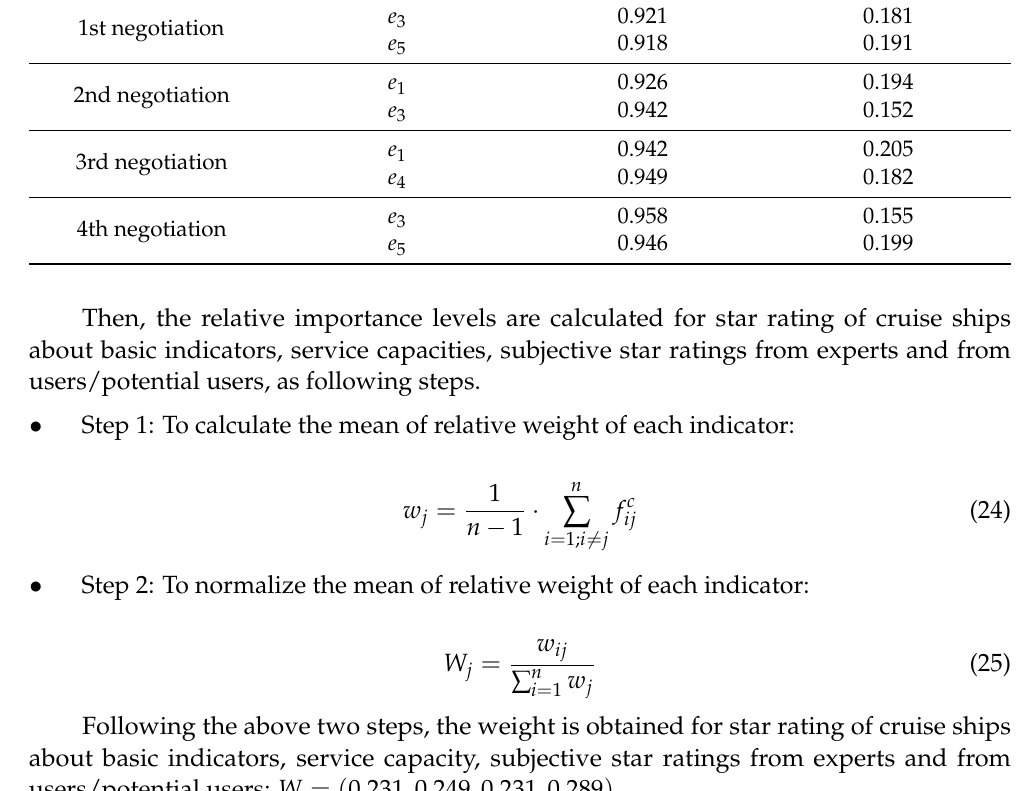
Table 4. Related indicators in each round of negotiation. Negotiation Round